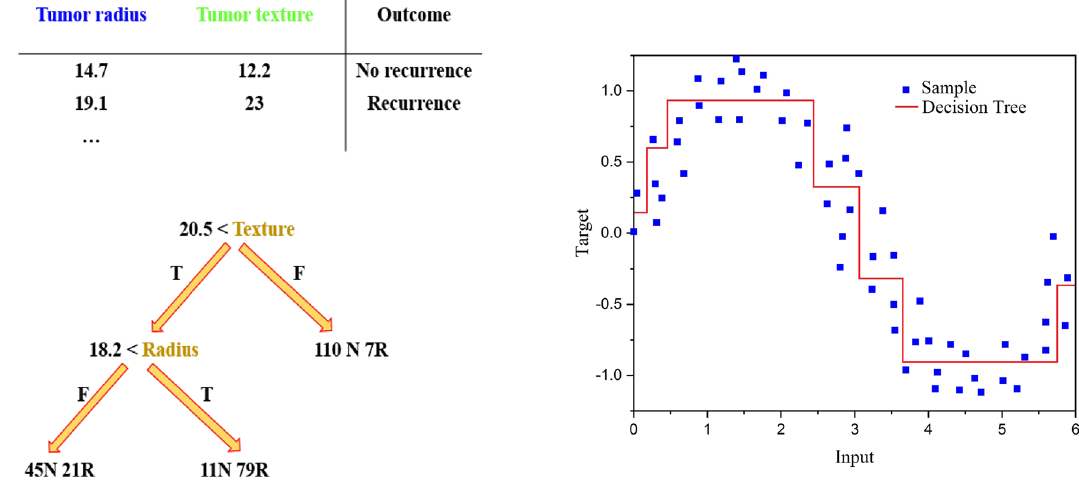
Figure 2. The schematic diagram of